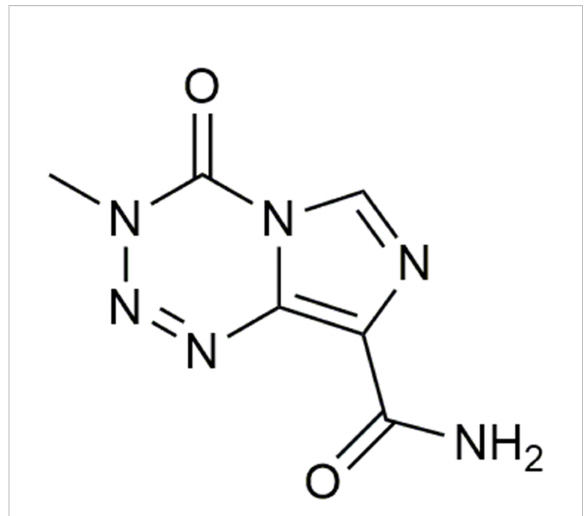
FIGURE 1 Structural formula of TMZ. Chemical name: 3,4-dihydro-3-